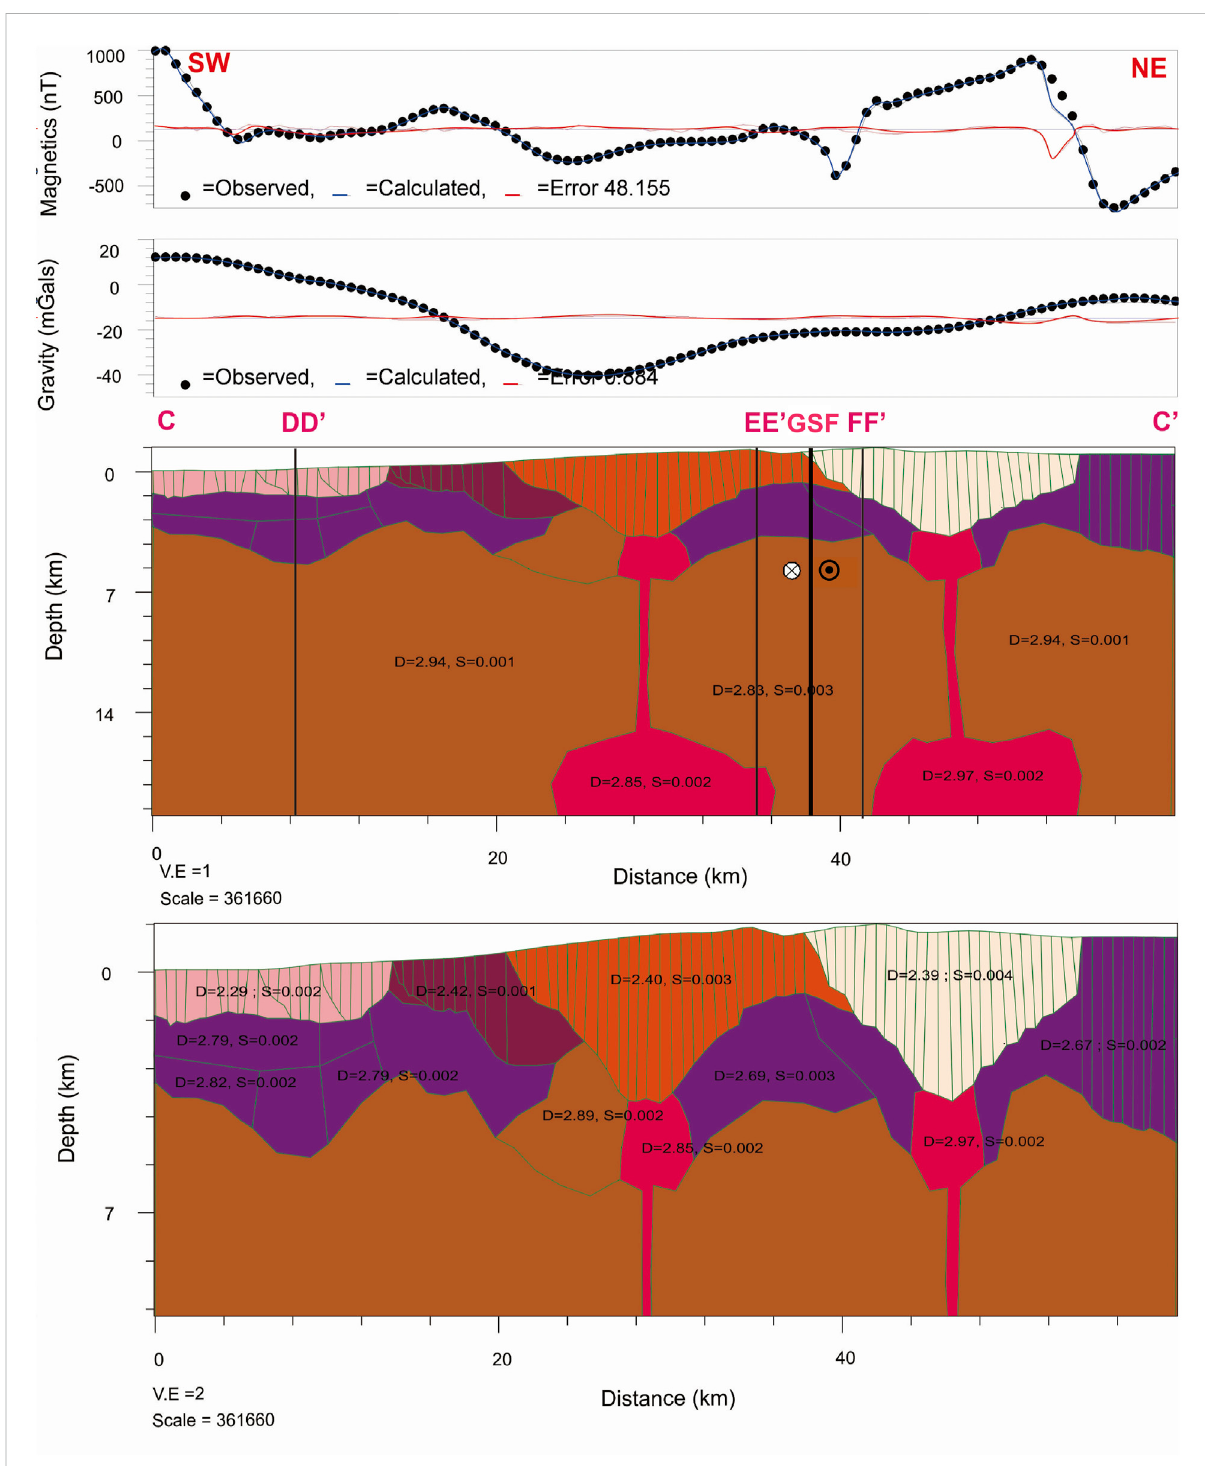
FIGURE 5 2D modeling of magnetic and gravity data of the C-C ′ pro fi le in the Sianok segment of GSF showing the subsurface structures beneath Mount Singgalang-Tandikat and beneath Mount Marapi that include their shallow and deep magma chambers. Note that the deep magma chamber of Marapi is signi fi cantly shallower than that of Singgalang-Tandikat. This fi gure uses the same legend as that in Figure